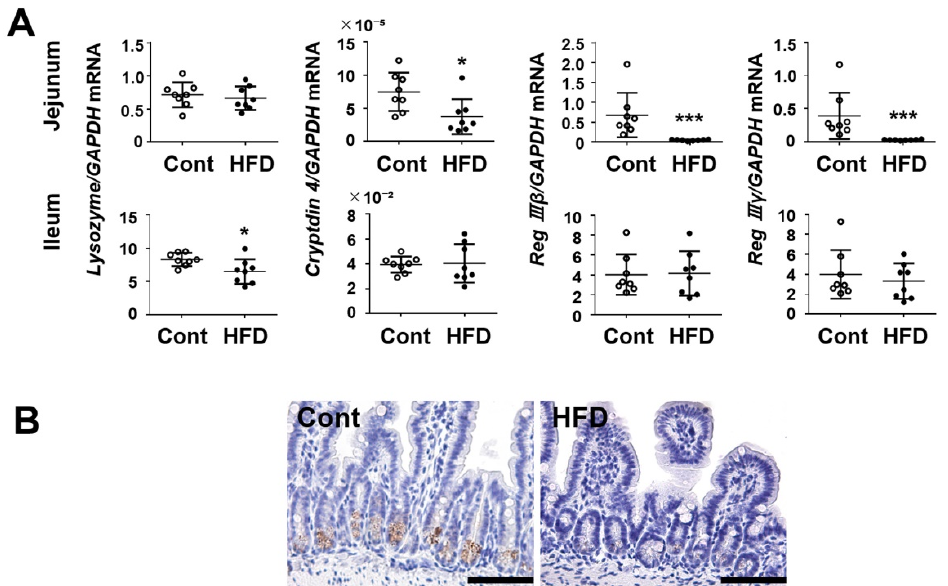
Figure 5. ( A ) Effect of a HFD on mRNA expression of antimicrobial peptides in mouse small-intestinal tissues. ( B ) Immunostaining of lysozyme in the ileum. Bar = 100 μ m. Results are expressed as the mean ± SD. * p < 0.05; *** p < 0.001 vs. control group. Cont, control ( n = 8); HFD, high-fat diet ( n = 8).